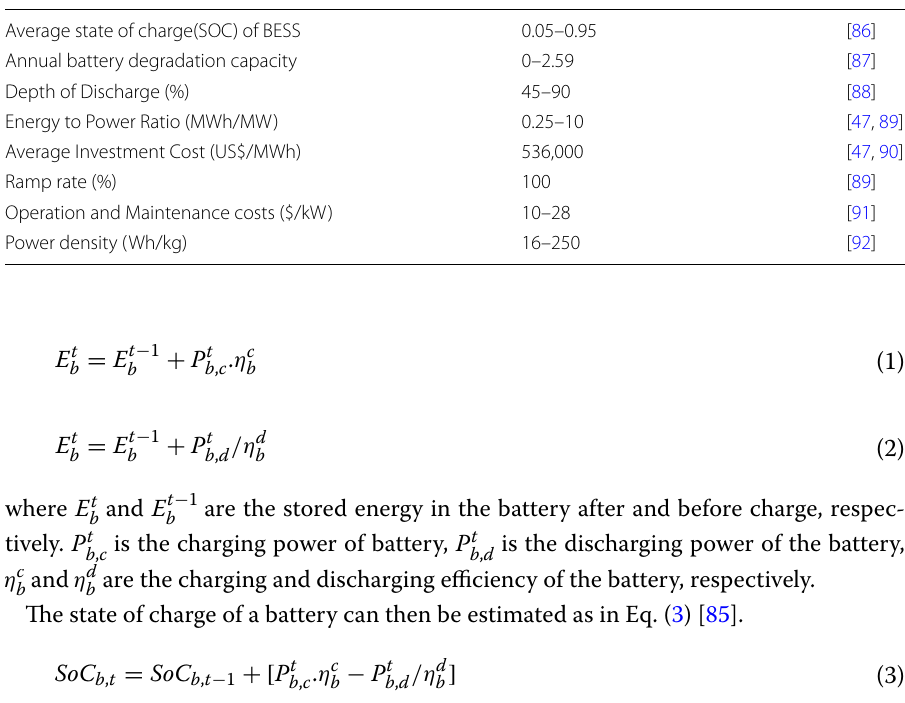
Table 1 Modeling features of BESS Modeling parameters Range of values